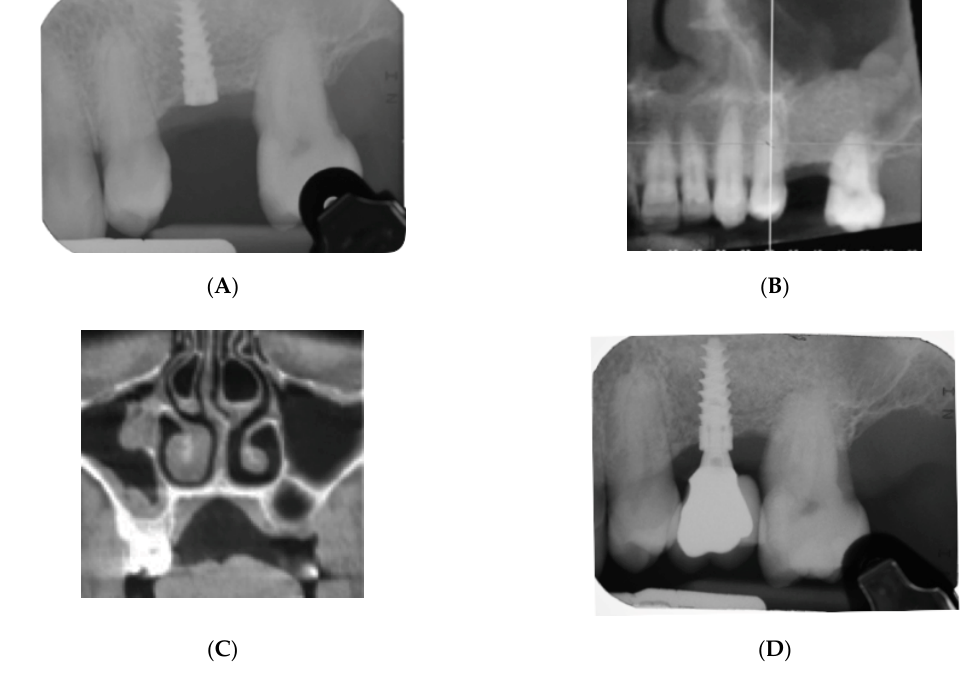
Figure 2. Radiographic images of a case with a residual bone height of 3.5 mm: ( A ) periapical radiograph showing posterior residual bone; ( B ) image taken soon after the procedure of lateral sinus lift; ( C ) implant positioned after 5 months; ( D ) 1-year follow-up after